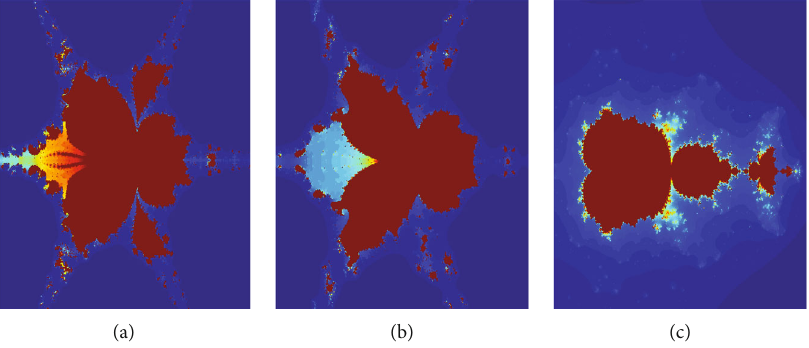
Figure 10: E ff ect of change in parameter t on cubic Mandelbrot set.